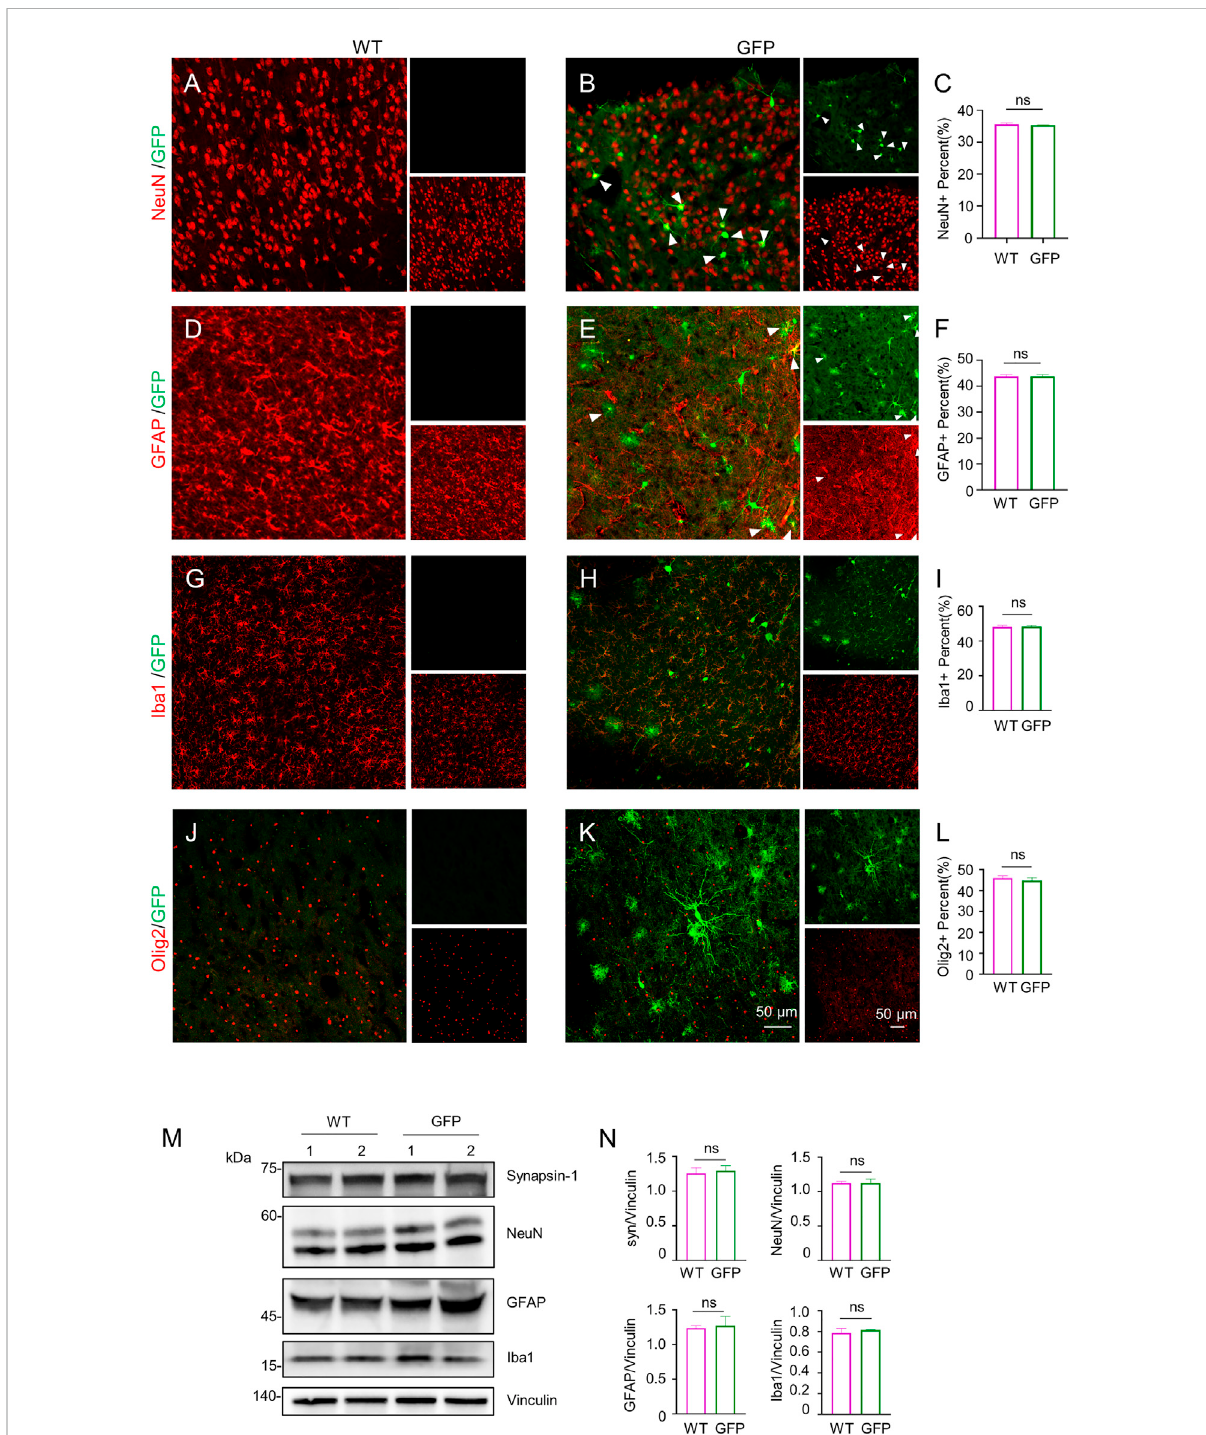
FIGURE 2 Immuno fl uorescent staining of the pig ’ s cortex injected with AAV-GFP or saline. (A – C) Double immuno fl uorescent labeling (A,B) and quanti fi cation (C) ofneurons (NeuN) of saline- or AAV-GFP-injected-wildtypepigs. GFP positive cells are shown in green (small images in theupper right),NeuNpositivecellsareshowninred(smallimagesinthelowerright).ThetrianglesindicatecellsthatarepositiveforbothGFPandNeuN. (D – F) Double-immuno fl uorescentlabeling (D,E) andquanti fi cation (F) ofastrocytes(GFAP)insalinecontrolorAAV-GFPinjectedpigs.Smallimagesin the upper right are GFP positive cells and in the lower right are GFAP positive cells. (G – I) Double-immuno fl uorescent labeling (G,H) and quanti fi cation (I) of microglial cells (Iba1) in saline control or AAV-GFP injected pigs. Small images in the upper right are GFP positive cells and in